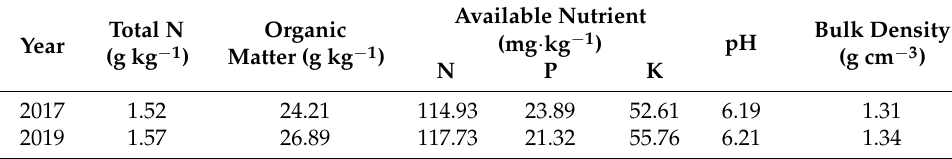
Table 1. Physicochemical characteristics of soil (0–20 cm) in the